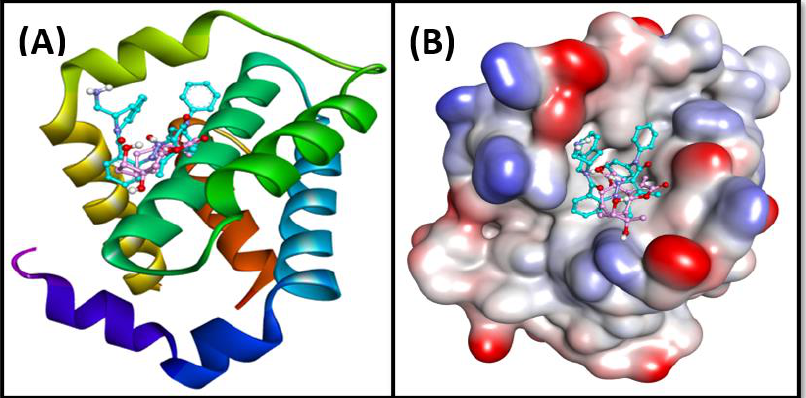
Figure 7. Binding of DRO and chlorojanerin at the active side of Bcl-2. ( A ) 2D cartoon representation, and ( B ) 3D representation of the active site and bound ligands.